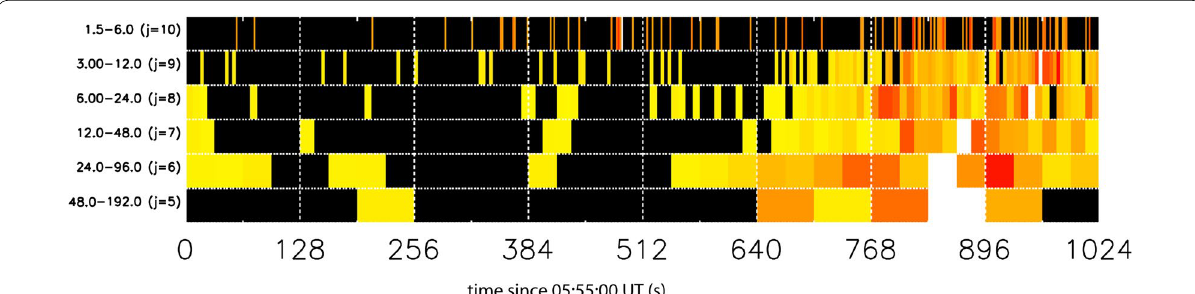
Fig. 3 AWESOME (Murphy et al. 2009a) analysis of the substorm in 2008-03-05/06:04:20 UT, run from 05:55:00 UT. Displayed in the figure are wavelet-derived power spectra as a function of time and wavelet period (s) or j (wavelet basis). The colours represent normalised wavelet coef- ficients, whereby black represents wavelet coefficients below the pre-determined threshold for each j and yellow-orange-red-white are coefficients rising above the threshold in increasing amplitude